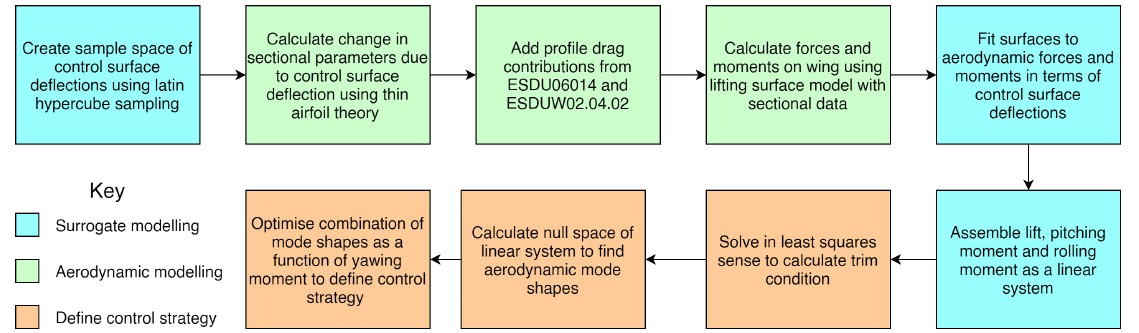
Figure 3. Process flow of control allocation